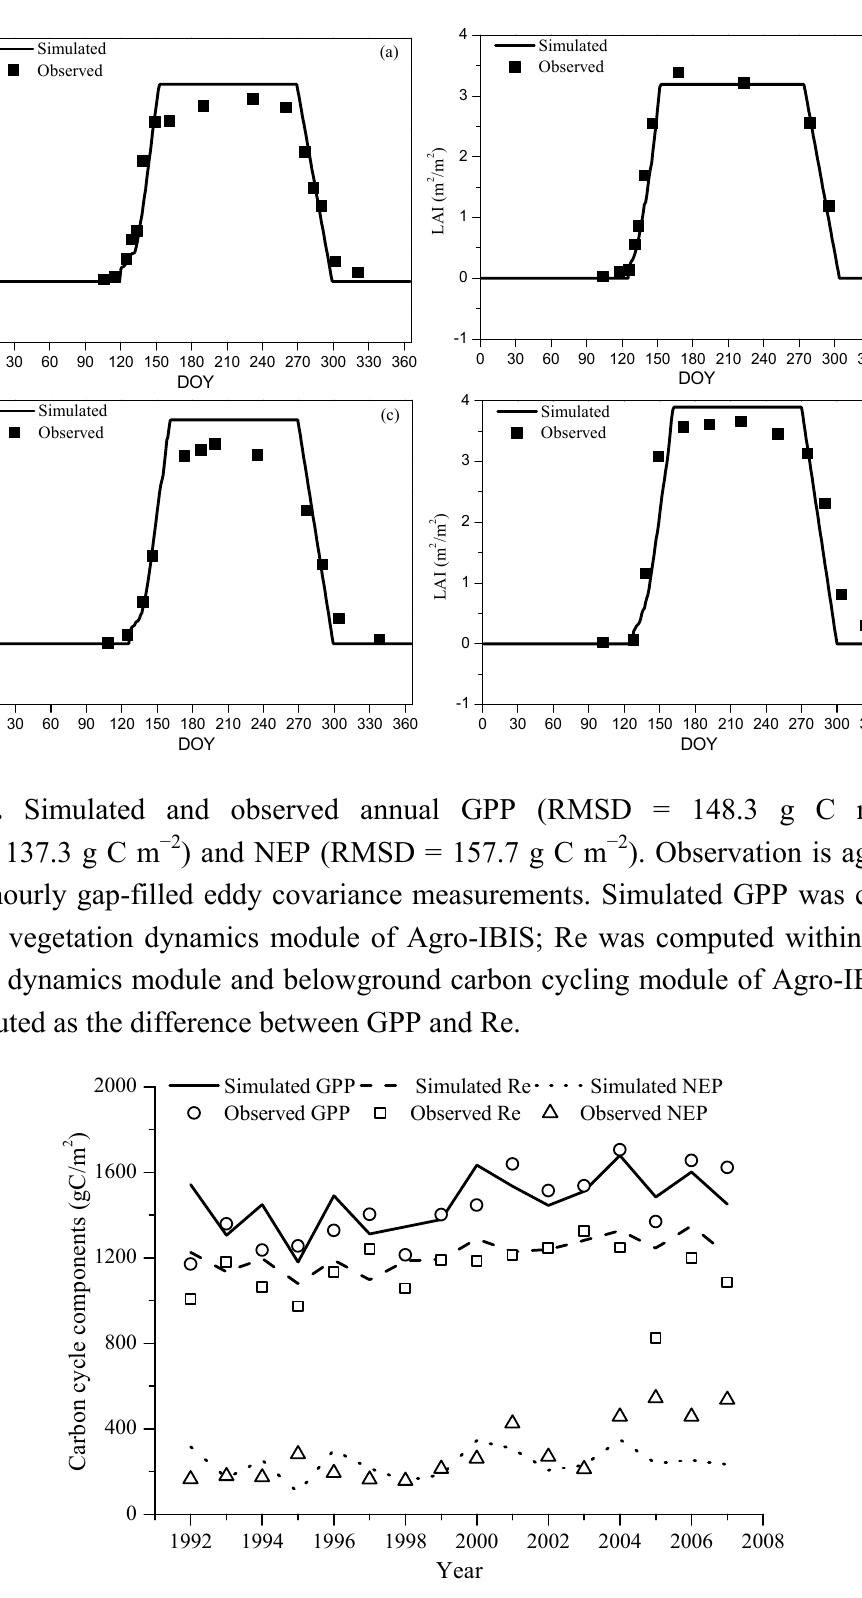
Figure 1. Simulated and observed LAI for 1998 (RMSD = 0.33) ( a ); 1999 (RMSD = 0.24) ( b ); 2006 (RMSD = 0.37) ( c ); and 2007 (RMSD = 0.53) ( d ). BBRK30 and LCOLOR20 were used in the Agro-IBIS simulation as leaf onset and offset, respectively. Observed LAI was measured using a LAI2000 sensor at Harvard Forest AmeriFlux site.